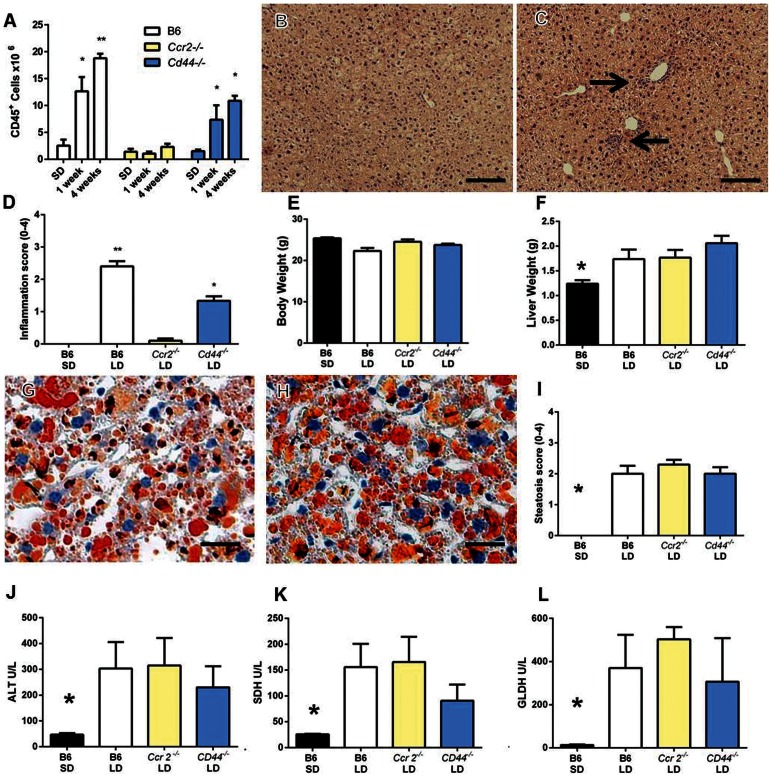

Ccr2−/− and Cd44−/− mice are resistant to hepatitis during LD feeding despite lipid accumulation and elevated serum enzymes.(A) Infiltration of CD45+ inflammatory cells into the livers of B6, Ccr2−/−, and Cd44−/− at one and four weeks of LD or SD feeding (*P<0.05 compared to SD controls, **P<0.05 compared to all groups, n = 3–6 per group). (B and C) Respective low power images from Ccr2−/− and Cd44−/− mice fed the LD for four weeks. In C, arrows point to inflammatory infiltrates restricted to large liver vessels. (D) Histological scoring of mice confirms moderate to severe inflammation in B6 LD mice and mild to moderate inflammation in Cd44−/− mice (**P<0.05 compared to all groups, *P<0.05 compared to SD fed or Ccr2−/− LD fed mice; scores represent means of n = 6–12 mice per group). (E) Lithogenic diet feeding did not induce obesity in any genotype. (F) Lithogenic diet feeding induced significant hepatomegaly in all strains (*P<0.05 compared to all other mice, n = 4–6 per group). (G–H) Oil-red-o staining of livers from Ccr2−/−(G), and Cd44−/− (H) mice demonstrate an accumulation of excess lipid irrespective of genotype. (I) Steatosis scoring demonstrates a significant increase in steatosis in all genotypes in response to LD feeding for 4 weeks compared to SD fed mice (**P<0.05 compared to all groups n = 6–10 mice per group). (J–L) Serum levels of hepatic enzymes are elevated in LD fed mice irrespective of genotype. (J and K, *P<0.05 against all LD groups; L, *P<0.05 compared to LD fed B6 and Ccr2−/− mice; n = 4–5 per group). B and C, bar represents 100µm; G–H, bar represents 20µm.